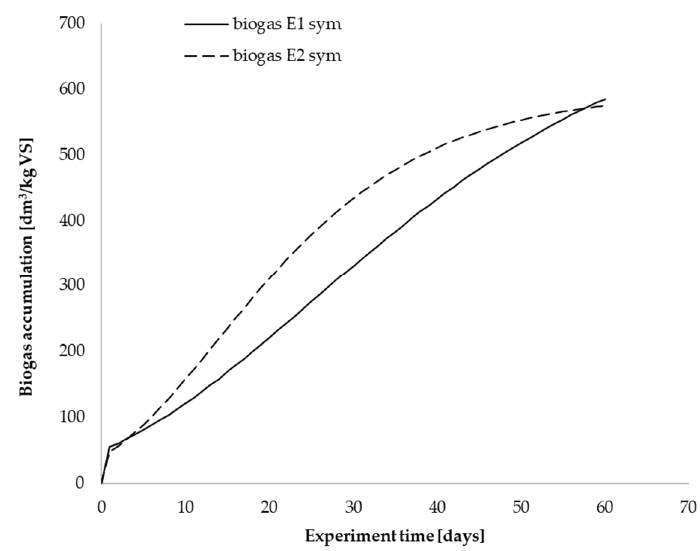
Figure 7. Simulation curves of biogas accumulation for E1 and